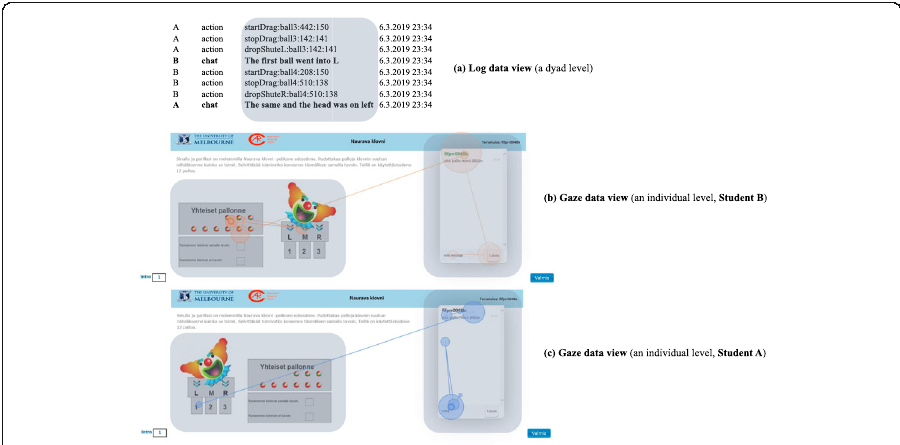
Fig. 5 Illustration of a common attention experience (students B and A perspectives) whilst completing the ‘ Laughing Clowns ’ task. The example includes simultaneous moments from ( a ) the log data, combined with ( b ) and ( c ) individual-level screen captures from the eye-tracking video